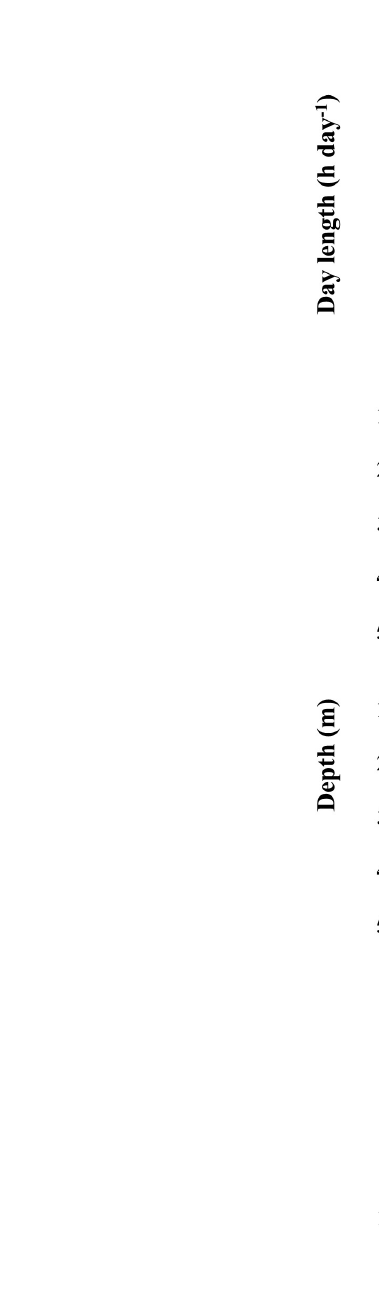
during the midnight sun ( p <0.001, Mann-Whitney U -test), whereas G. brevispinus showed a deeper distribution during the polar night compared to that during the midnight sun ( p <0.01). The deepest dwelling species, the two Aetideopsis spp., showed no differences in their D 50% between the polar night and the midnight sun ( p >0.05).